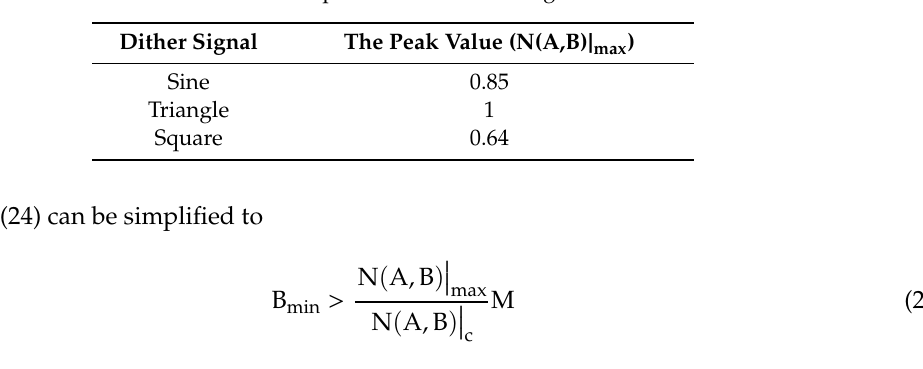
Table 1. The peak value of dither signal.